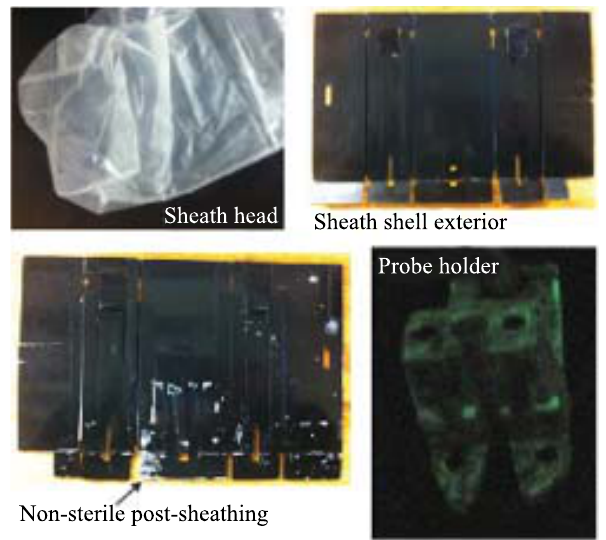
Figure 8. Results of testing with phosphorescent paint coated probe to demonstrate no probe contact outside of the sheath. Top two im- ages show lack of sheath and outer shell contact with probe.